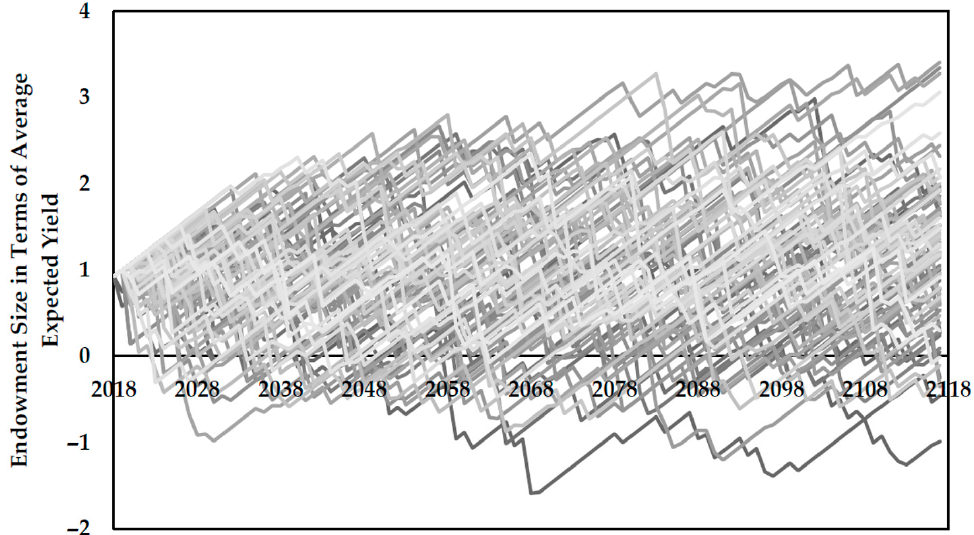
Figure 7. Size and fluctuation of annual endowment for 100 stochastic simulations with 7% premium; initial endowment is 0.9 AEY.